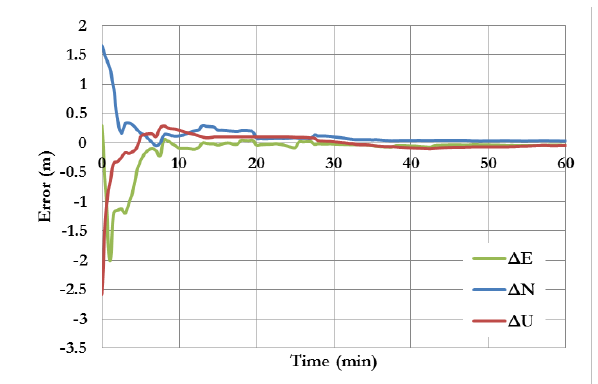
Figure 3: The positioning results of the GPS-only PPP